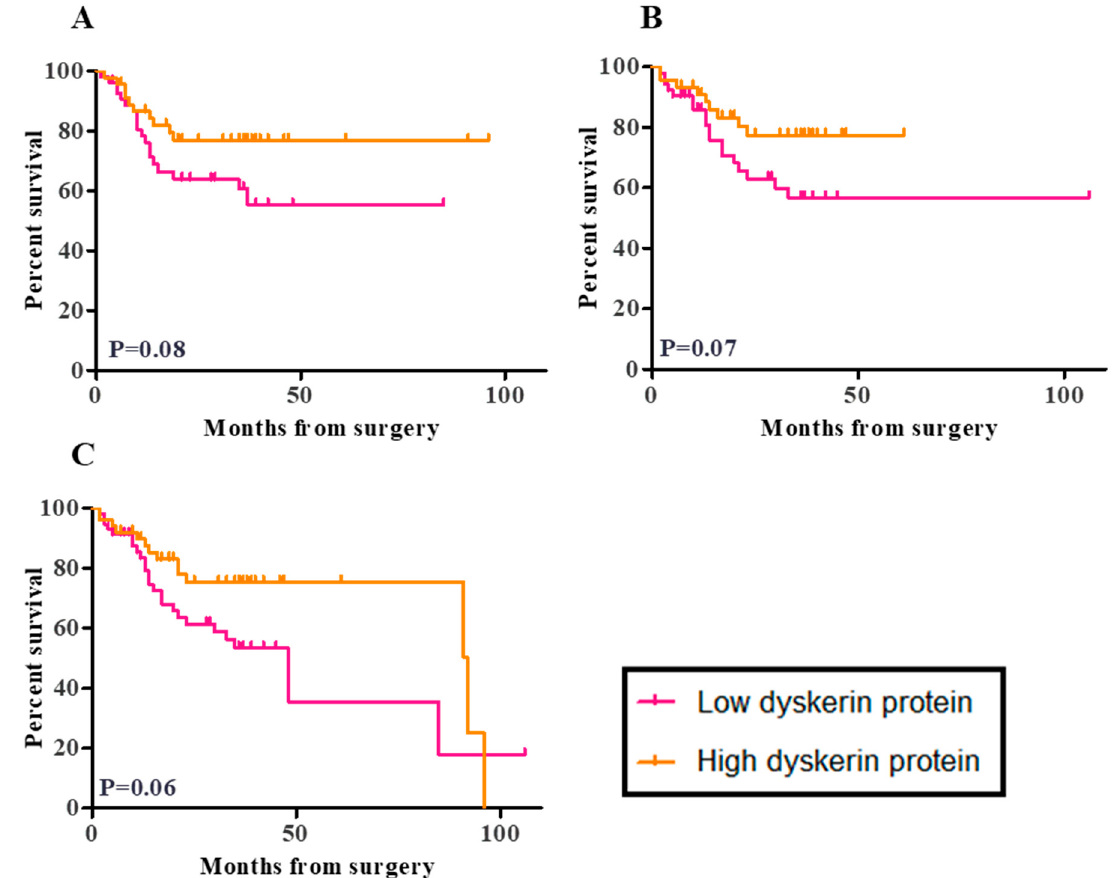
Figure 5. Kaplan Meier survival curves for the correlation between dyskerin immunoscores and patient outcome. ( A ) Disease-free survival (DFS), the median DFS time is undefined for low dyskerin and high dyskerin endometrial cancer groups. Hazard ratio (HR) = 1.92, 95% CI of the ratio (0.9200–4.006) ( B ) Cancer-specific survival (CSS), the median CSS time was undefined for low dyskerin and high dyskerin endometrial cancer groups. HR = 1.991, 95% CI of HR (0.9300–4.261) and ( C ) Overall survival (OS) in endometrial cancer samples ( n = 109). Median OS time: Low dyskerin protein 8.00 months, High dyskerin protein 2.00 months. Low dyskerin/high dyskerin median survival Ratio: 0.5217, 95% CI of ratio (0.004444–1.039) HR = 1.841, 95% CI of HR (0.9667–3.506). A quickscore of 6 was chosen as the cut-off point. The p values relevant to the difference between low and high dyskerin protein levels in endometrial cancer groups that is visually represented in Kaplan Meier survival curves from the log-rank